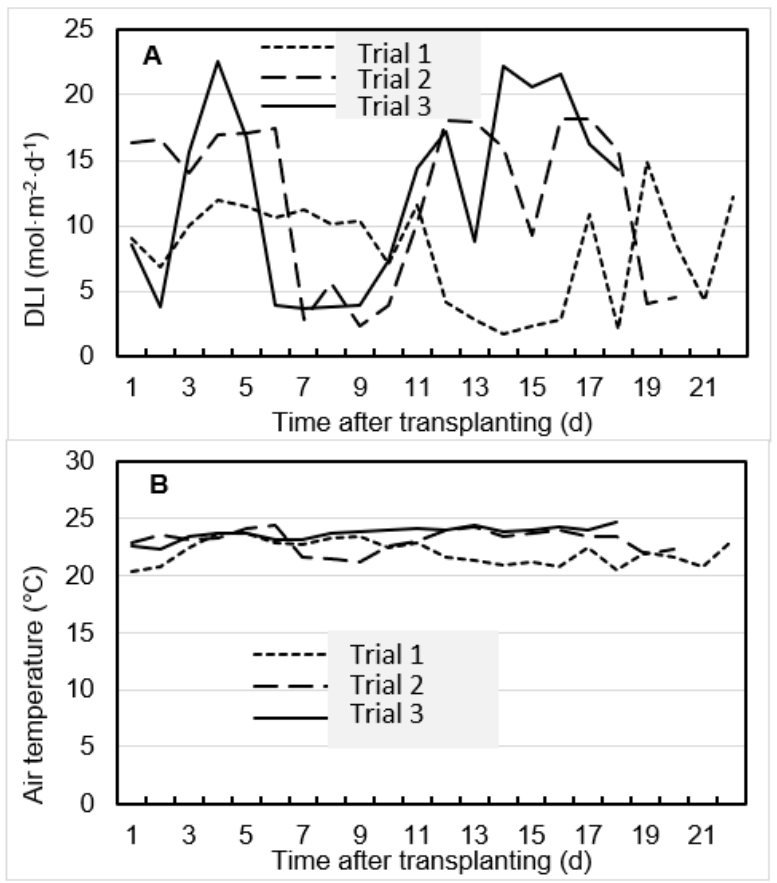
Figure 1. Daily light integral (DLI, mol·m − 2 ·d − 1 ) ( A ) and daily average air temperature (°C) ( B ) inside the greenhouse collected between transplanting and harvest.